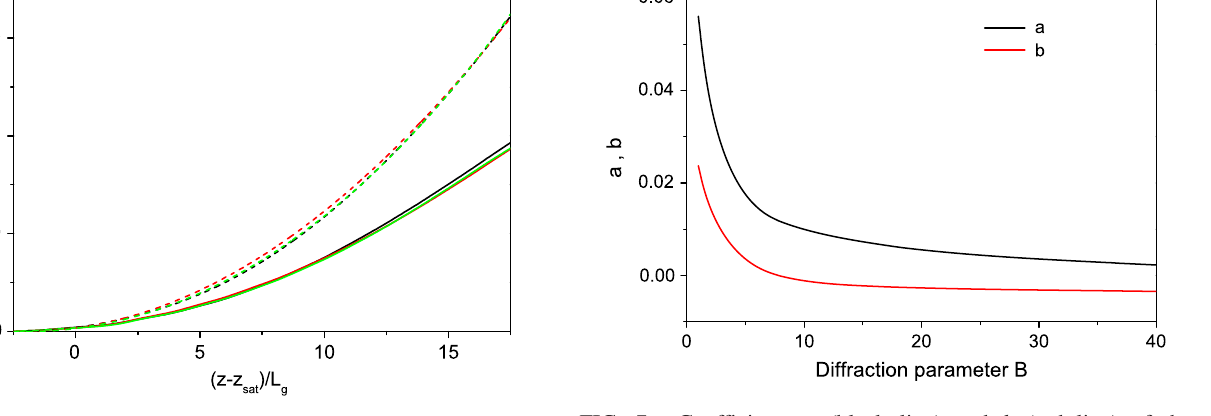
FIG. 6. Evolution along the undulator of the reduced radiation Þ (solid curves) and of the detuning power ˆ η ¼ W= ð ρ W beam ˆ C ¼ C= Γ (dashed curves). Color codes: black — FEL parameter with global optimization of undulator tapering; red — fit with the formula (5); green — fit with the rational function (6). Here the value of the diffraction parameter is B ¼ 10 .